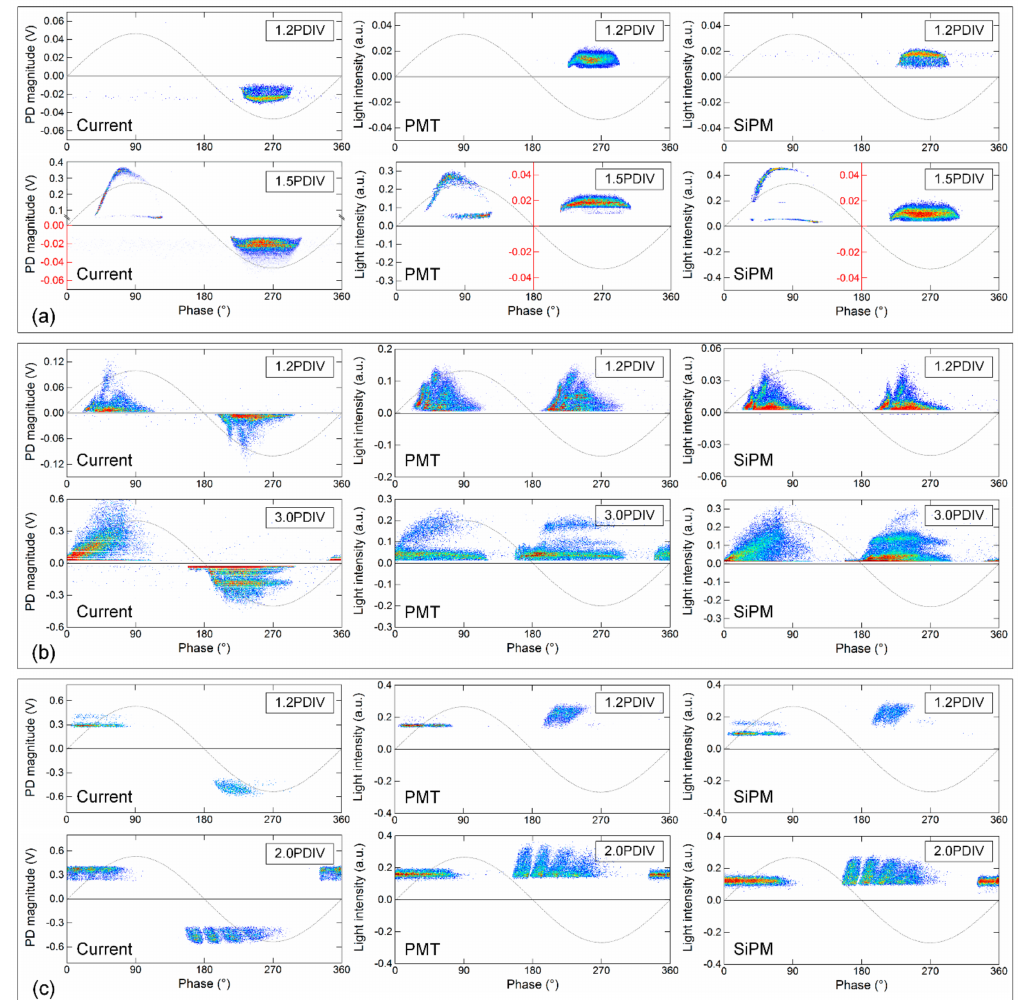
Figure 11. Phase-resolved PD pattern (PRPD) patterns of PD light intensities detected by HFCT, PMT and SiPM at different levels of PD activity. ( a ) Point discharge; ( b ) surface discharge; ( c ) floating discharge. The tests are performed in air condition. The over-voltages applied to SiPM and PMT are 2.5 V and 800 V, respectively. The noise level of the PD current pulse detection is below 0.5